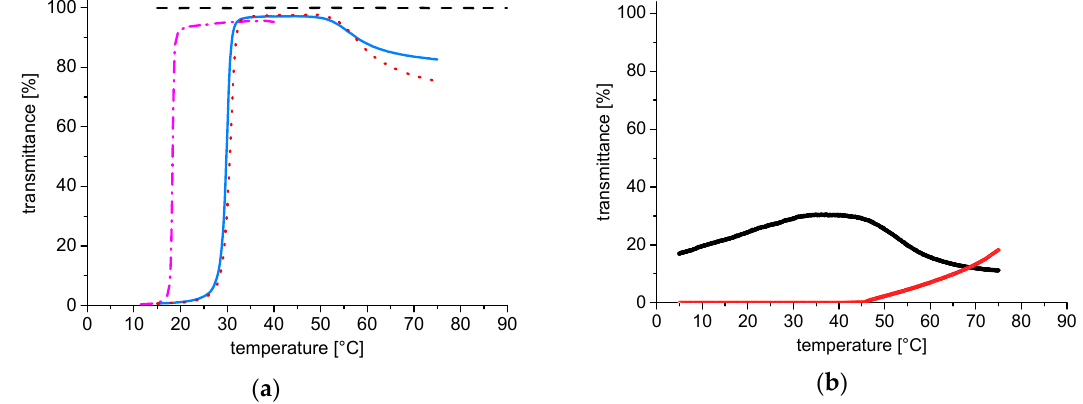
Figure 5. Temperature dependent turbidity of 30 g·L − 1 aqueous solutions of sulfobetaine polymers: ( a ) PSPE-1 ( - · - · - ), mPEG-Br ( - - - - ), and 1:1 w / w mixture of PSPE-1 and mPEG-Br in cooling ( — ) or ( ····· ) heating runs; ( b ) cooling runs of block copolymers PEG- b -PSBE-1 ( — ) and PEG- b -PSBE-2 ( — ).